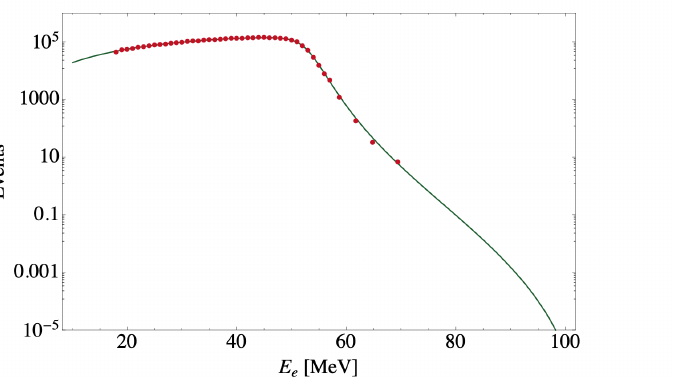
Figure 16. Energy spectrum of the DIO electrons (solid line) fitted to TWIST data (dots ) [169]. Figure from